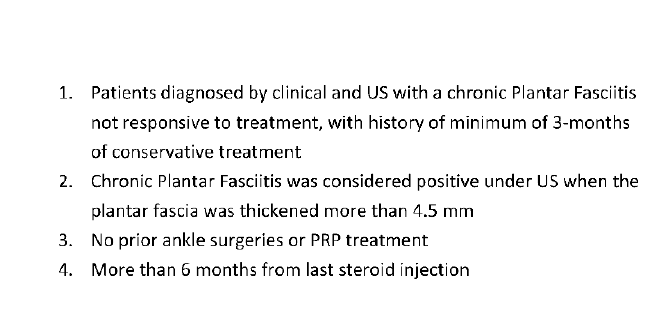
Figure 1. Inclusion criteria. PRP: Platelet-Rich Plasma.